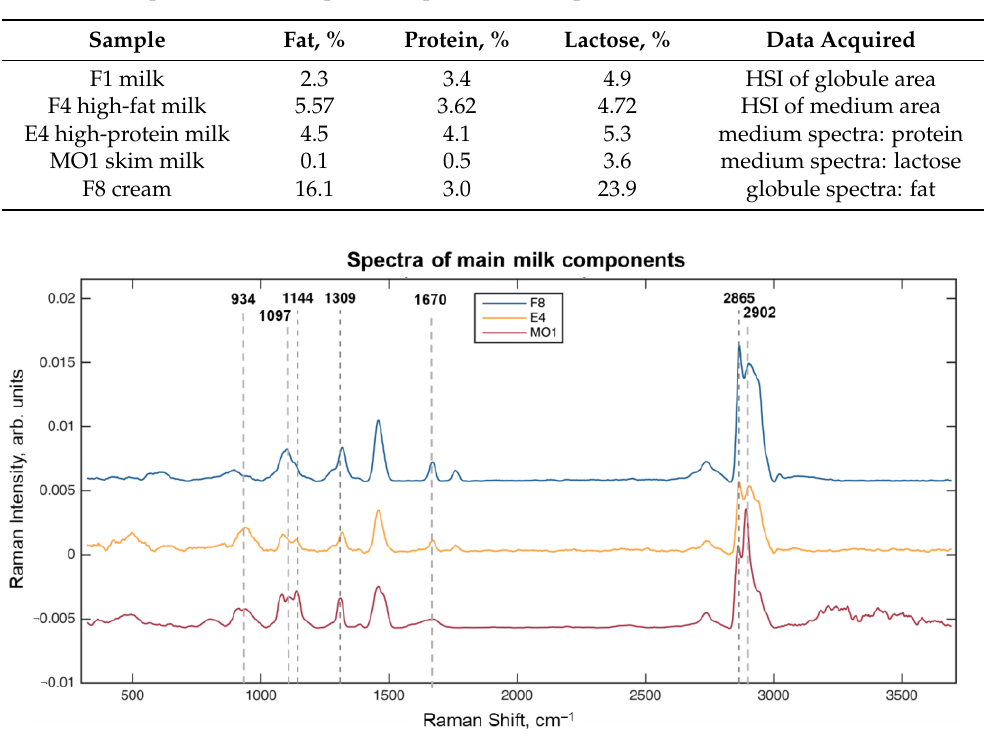
Table 1. Description of milk samples and spectral data acquired.